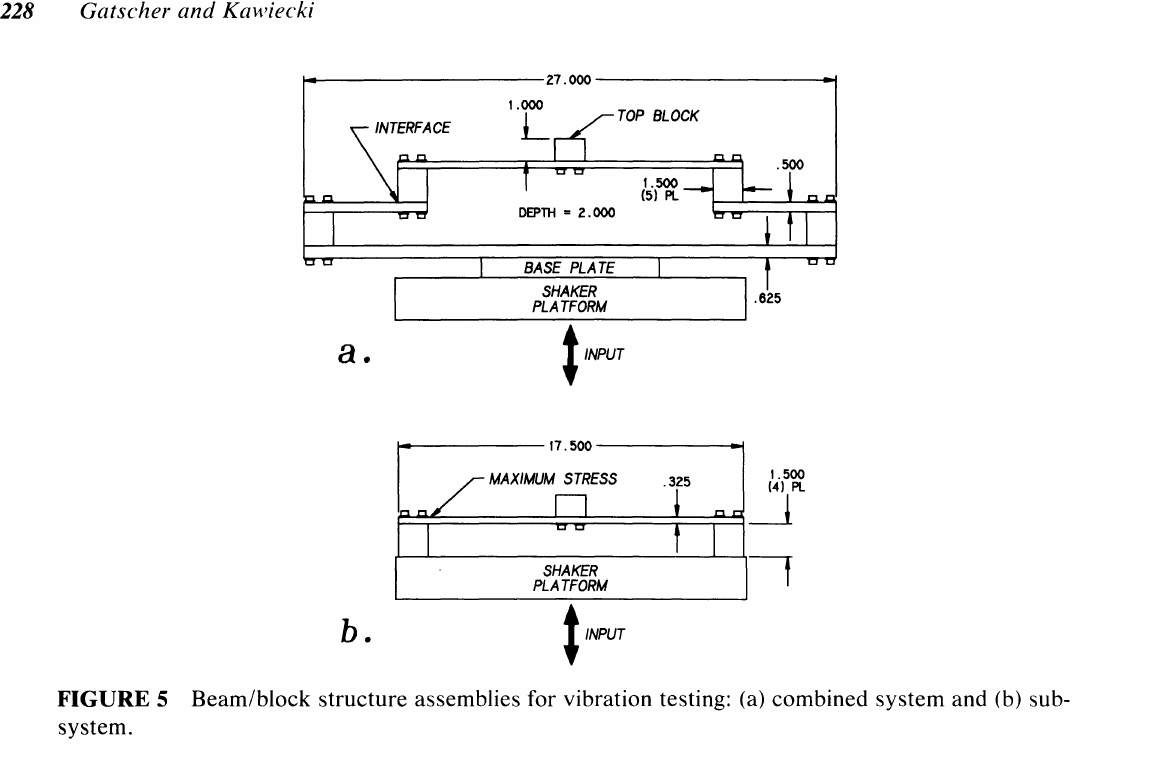
FIGURE 5 Beam/block structure assemblies for vibration testing: (a) combined system and (b) sub system.